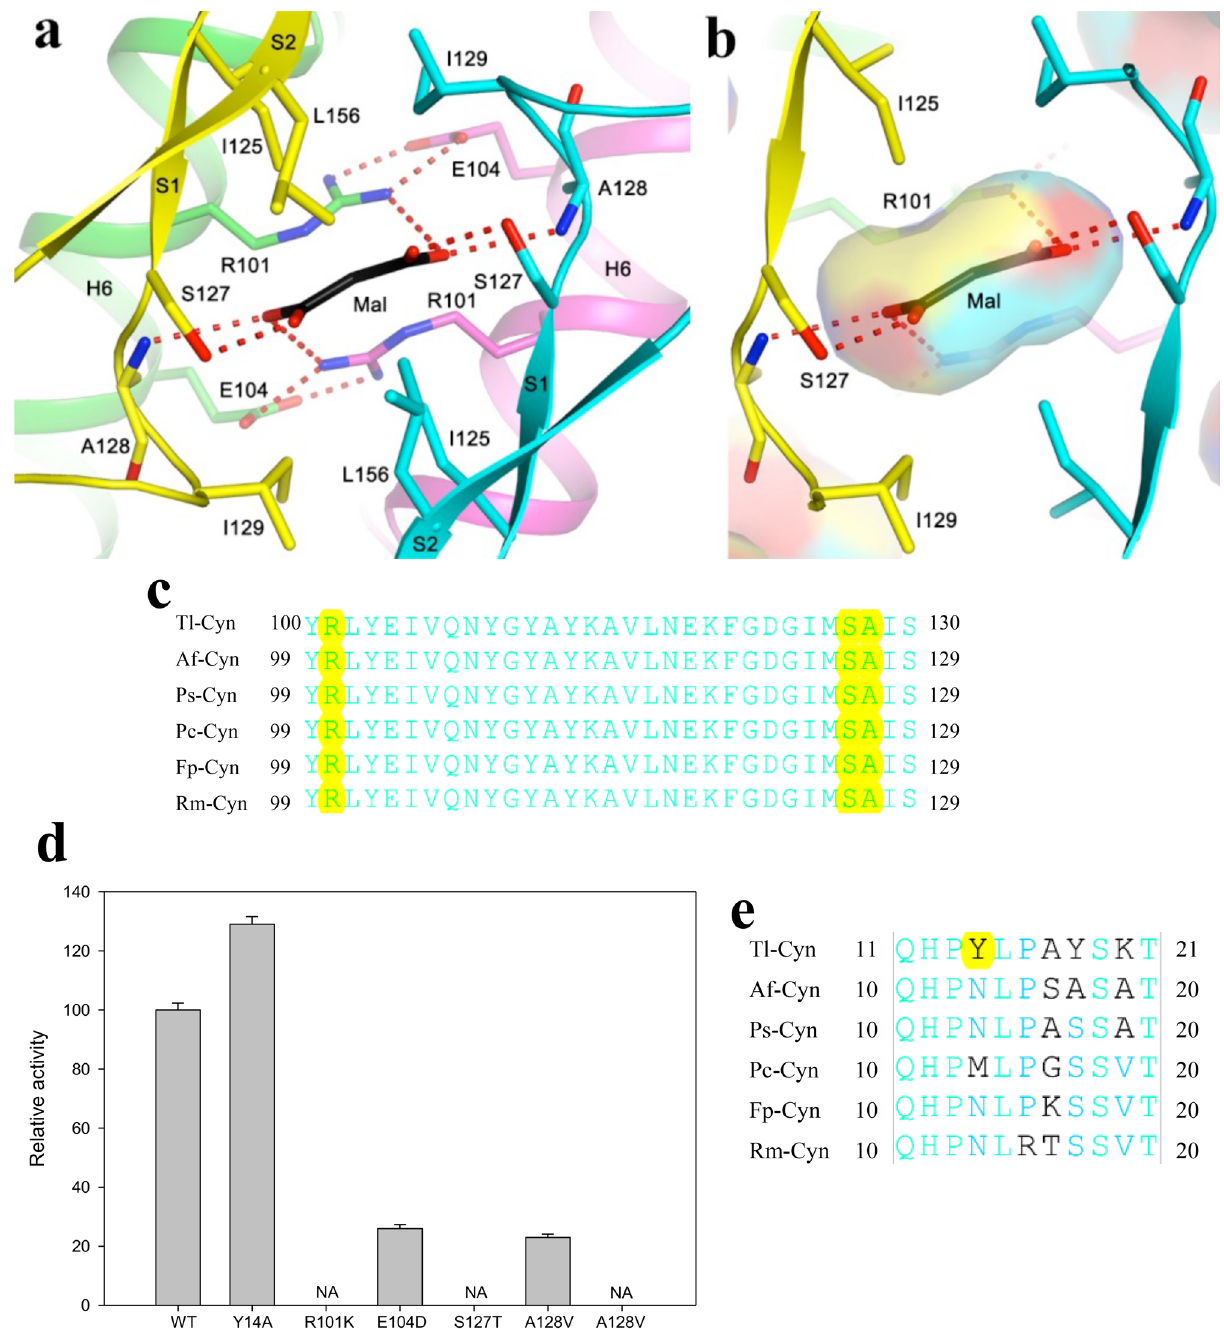
Figure 3. Structural insights into the catalytic mechanism of Tl-Cyn. ( a ) Schematic drawing of the detailed interactions between Tl-Cyn and the malonate molecule bound in the active site (sticks model and labeled Mal). Hydrogen-bonding interactions with the malonate are indicated with dashed lines (red). ( b ) Close-up view to that in ( a ), and the internal cavity for malonate is shown with semi-transparent surface. ( c ) Conserved sequence near the active site region of the C-terminal domain in fungal cyanases are shown in cyan. Residues that interact with Mal are shown with yellow background. Tl: Thermomyces lanuginosus , Af: Aspergillus flavus , Ps: Penicillium subrubescens , Pc: Phaeomoniella chlamydospora , Fp: Fonsecaea pedrosoi , Rm: Rhinocladiella mackenziei . ( d ) Catalytic activities of wild-type (WT) and mutant Tl-Cyn. The cyanate concentration is at 2 mM. The error bars represent the standard deviation from three independent measurements. NA, no activity observed under the condition tested. ( e ) Sequence alignment for the N-terminal domain of the fungal cyanases. Conserved residues are in cyan and a unique Y14 residue in Tl-Cyn is shown with yellow